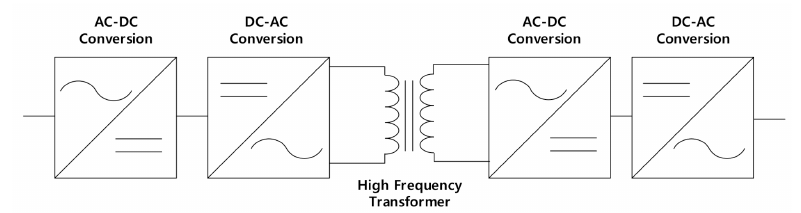
Figure 2. Diagram of a solid-state transformer